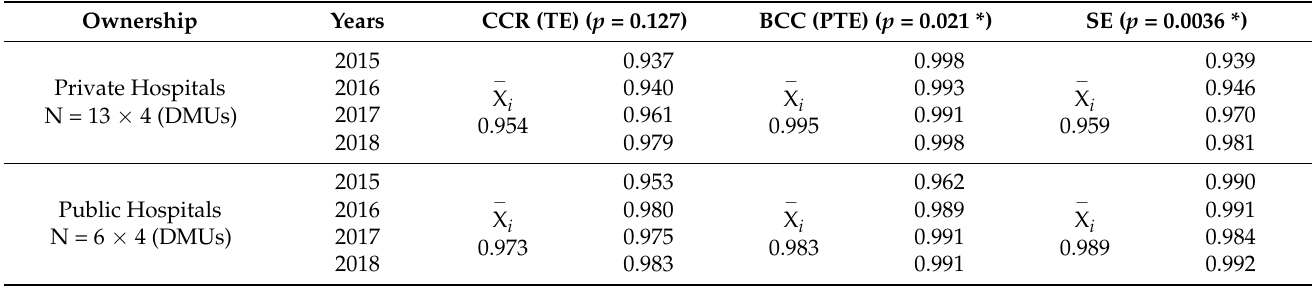
Table 7. The DEA average efficiency value of private and public tertiary hospitals.